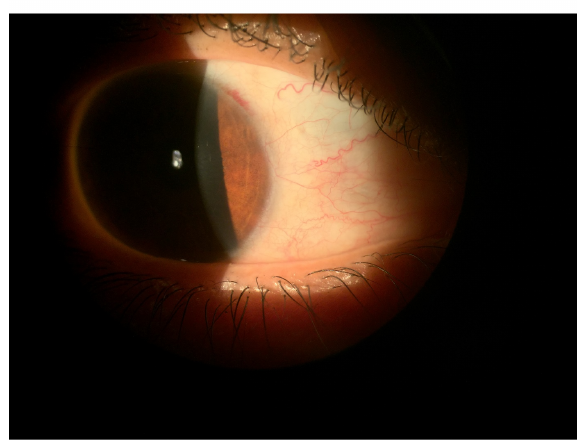
Figure 3: Slit-lamp image of the patient’s right eye 2 weeks after the onset of menstruation shows total resolution of subconjunctival